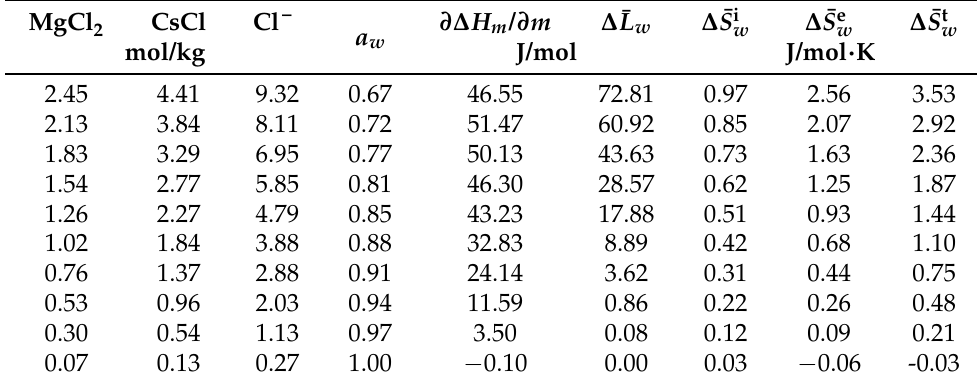
Table 3. The parameters obtained from dilution calorimetry experiment. MgCl